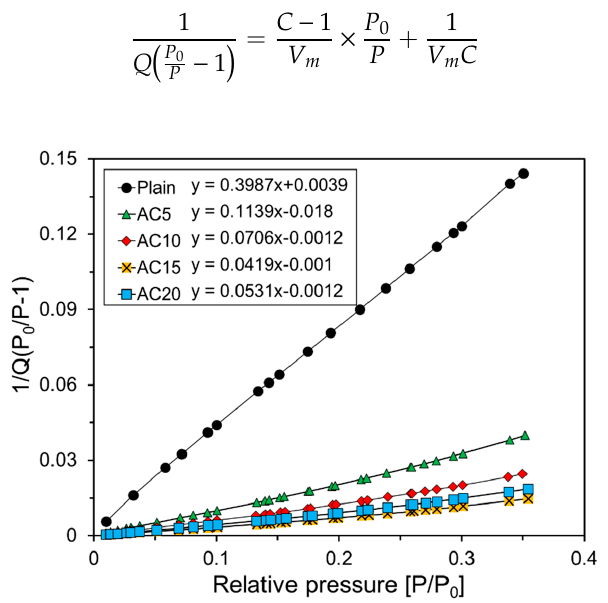
Figure 8. Specific surface areas of foam composites.